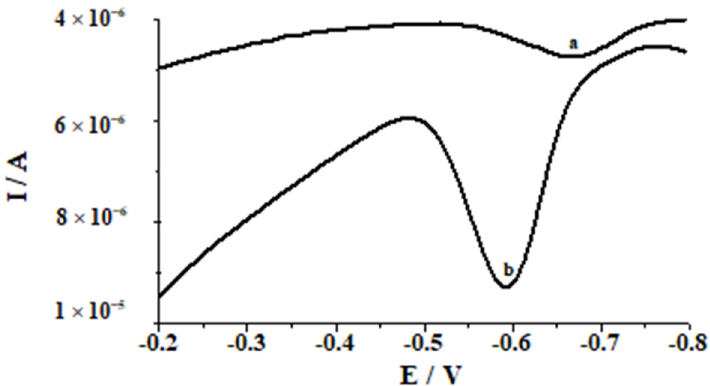
Figure 1. Voltammograms of Se(IV) obtained from solution: (a) without addition of Bi(III); (b) upon addition of 1.9 × 10 − 5 mol L − 1 . Steady concentration: 3 × 10 − 7 mol L − 1 Se(IV), 0.1 mol L − 1 acetic acid.